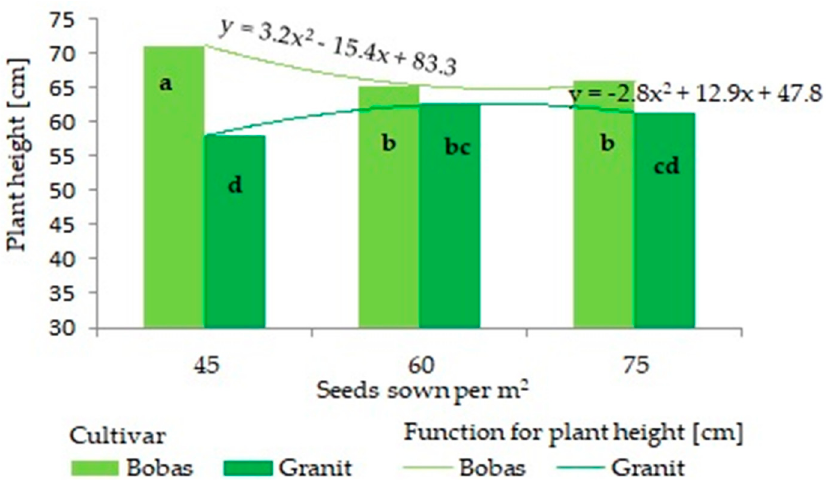
Figure 7. Plant height in 2011 (C × SDY). Different letters indicate significant differences between factors (Tukey’s multiple range test).